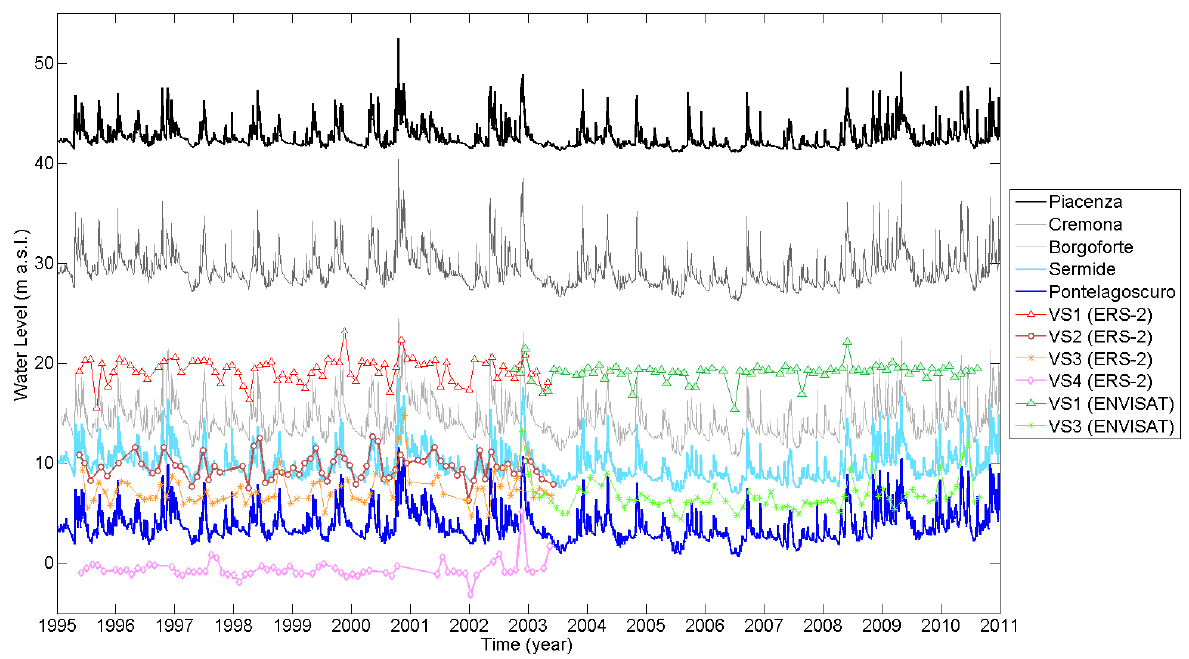
Figure 2. Water level time series of available in situ and virtual stations.